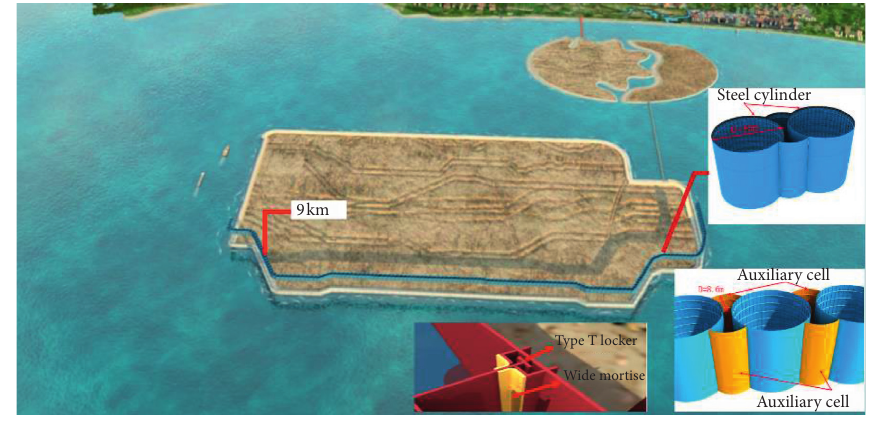
Figure 2: Steel cylinder quay